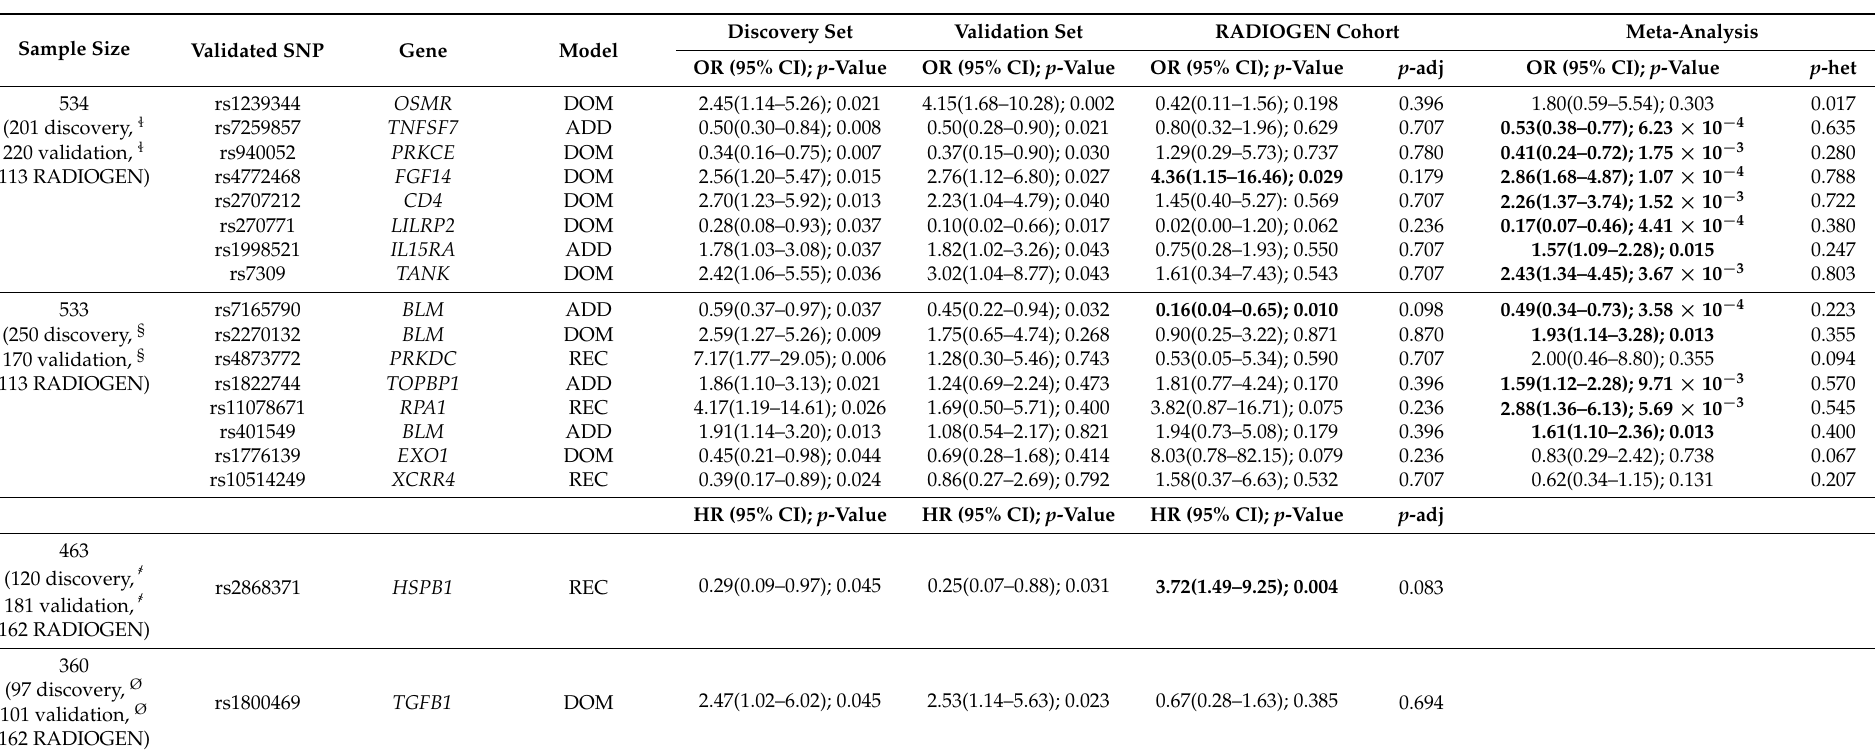
Table 2. Validation and meta-analysis of the SNPs identified in prior studies in association with radiation adverse effects in NSCLC patients including the RADIOGEN-Lung cohort.